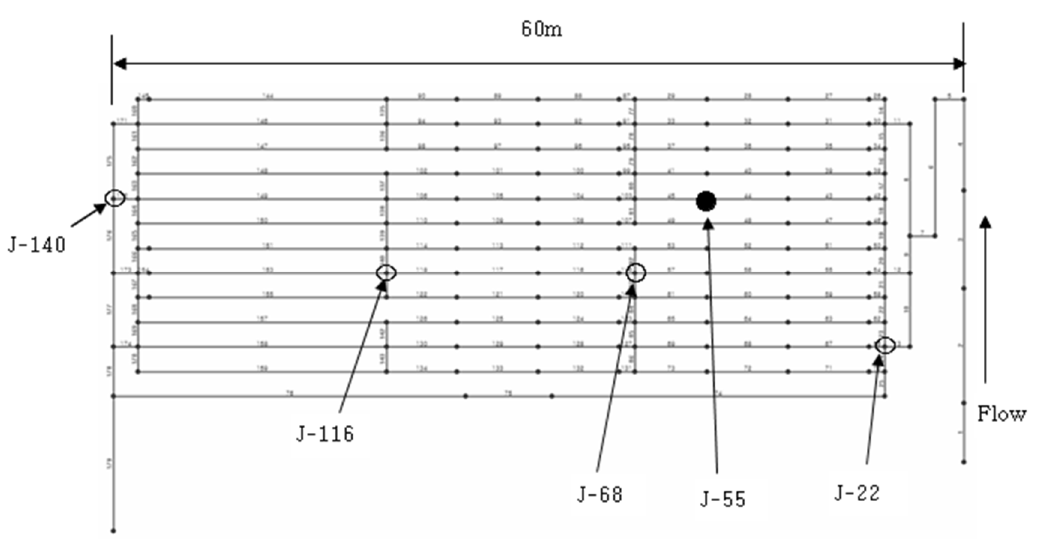
Figure 5. Plan view of pilot plant. Table 11. Results of pressure contribution and sensitivity